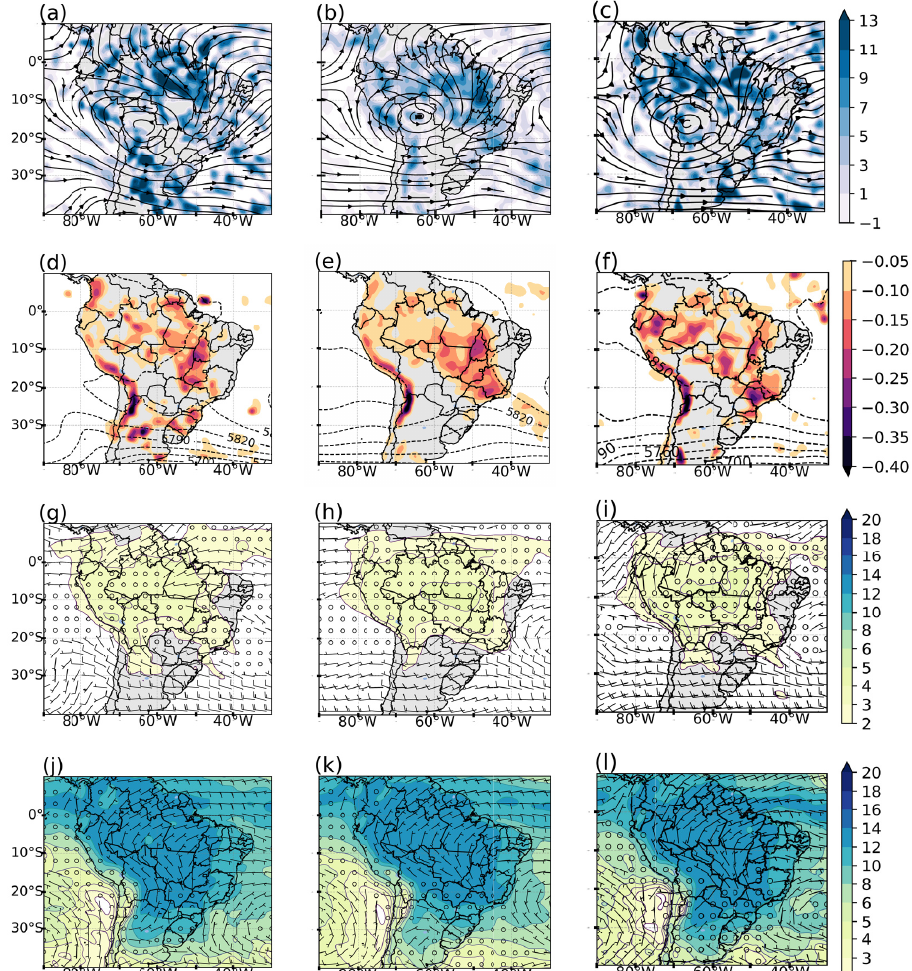
Figure 4. Composites of the streamlines and horizontal divergence of wind (1 × 10 − 5 · s − 1 ) at 250 hPa ( a – c ), geopotential height and omega (Pa · s − 1 ) at 500 hPa ( d – f ), specific humidity (g · kg − 1 ) and winds at 500 hPa ( g – i ) and at 850 hPa ( j – l ) for − 3D (left), 0D (center), and +2D (right) panels of the SACZ events during the unfavorable phase of the